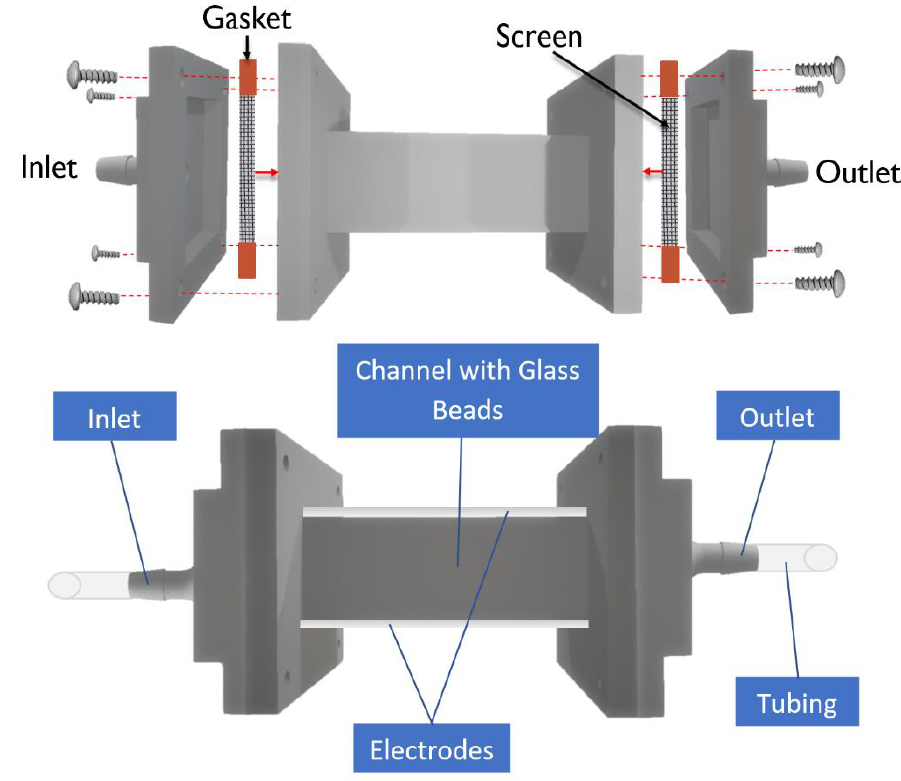
Figure 4. The layer-by-layer iDEP device assembly.